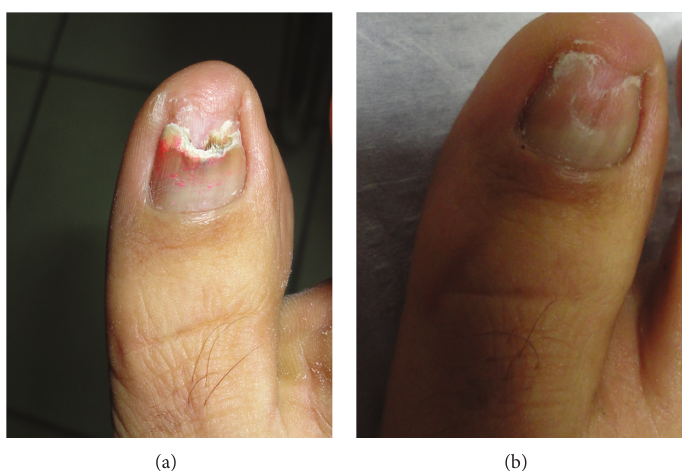
Figure 1: (a) 68-year-old female patient, before treatment. Trichophyton rubrum was isolated on mycological testing. Onychomycosis severity index (OSI) was 16. (b) After treatment with good improvement. OSI is 6 showing 69.5%